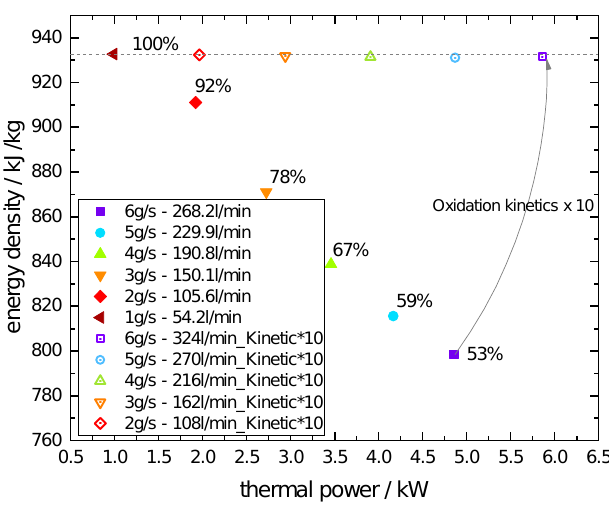
Figure 12. Energy density and thermal power of varied flow rates with either standard kinetics (full symbol) or accelerated kinetics (empty symbols). The numbers mark the conversion achieved for each simulated pair of flow